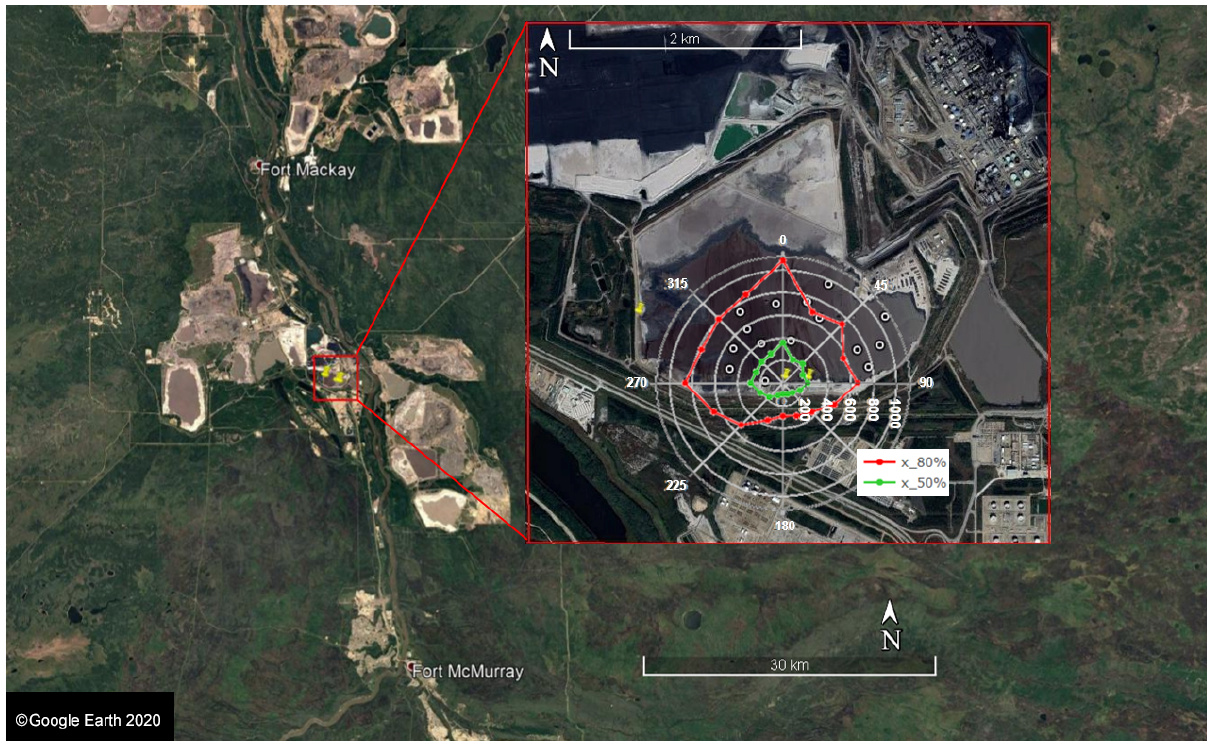
Figure 1. Overall map of the study site and close-up of the pond in September 2017. The superimposed polar plot shows the footprints under unstable conditions. Two traces in the polar plot show the medians of 80% and 50% contribution distances (in meters) for the measured half-hour EC fluxes in 16 wind direction bins. Angles in the polar plot are the wind direction (true north) with the center at the main site. The 15 white circles on the surface of the pond indicate the locations of the flux chamber measurements. The gray areas north of the r = 1100m circle are sandy deposits; dark gray represents liquid